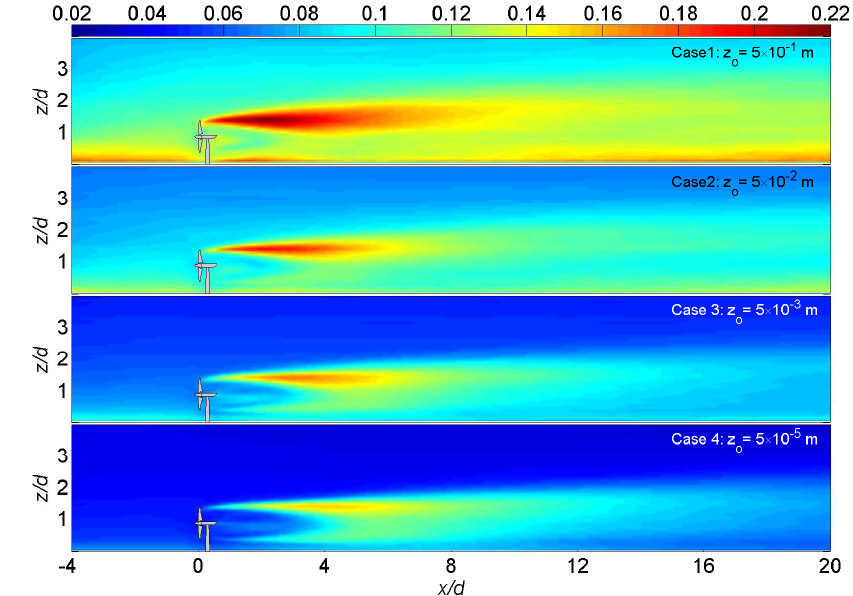
Figure 6. Contours of the streamwise turbulence intensity I vertical plane perpendicular to the turbines installed over flat surfaces with different roughness lengths.